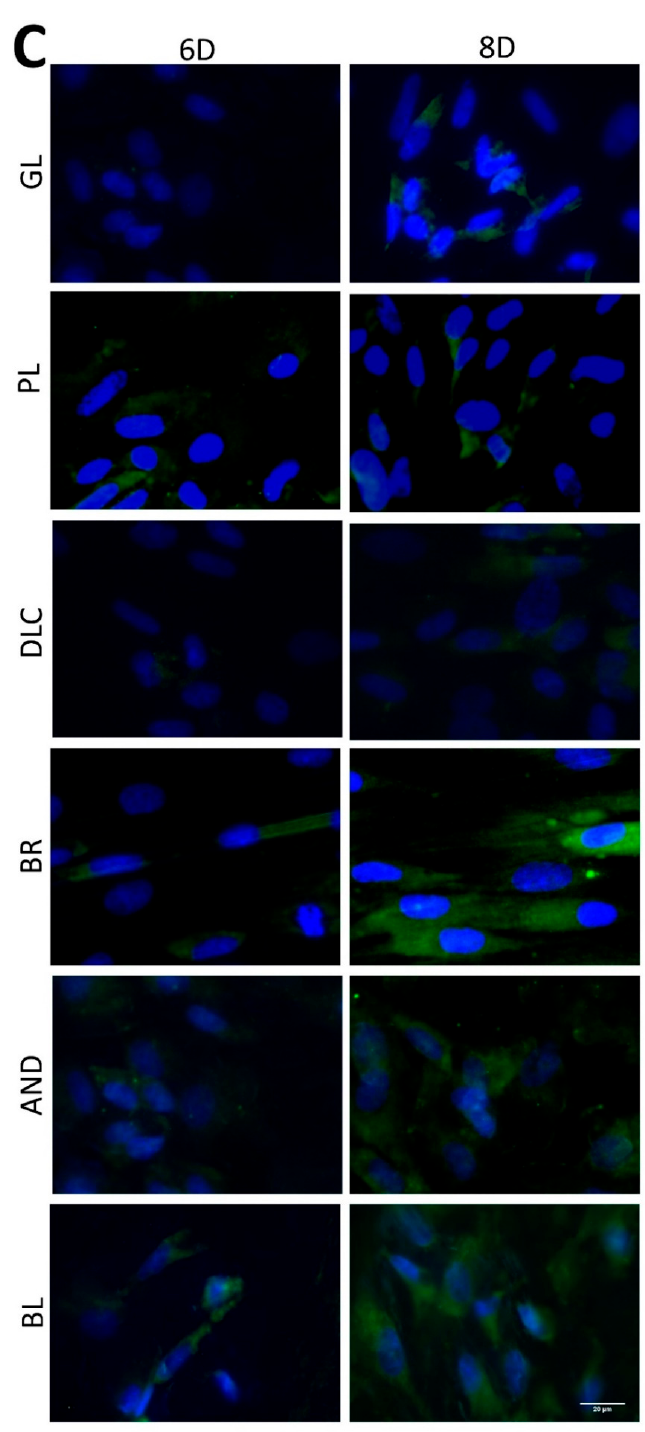
Figure 7. Immunofluorescence staining of early osteogenic markers RUNX2 ( A ) and COL1 ( B ) and an intermediate marker OPN ( C ) in cells on the reference glass coverslips (GL) and on the Ti6Al4V samples modified by polishing (PL), by DLC-coating (DLC), by brushing (BR), by anodizing (AND), or by blasting (BL) on days 3, 6, and 8 of cultivation. Leica DMi8 microscope, scale bar 20 μ m.